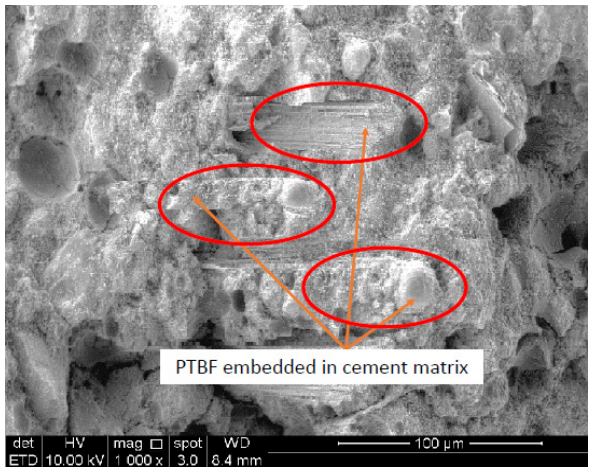
Figure 23. SEM micrograph of LFC with 2.5% PTBF.